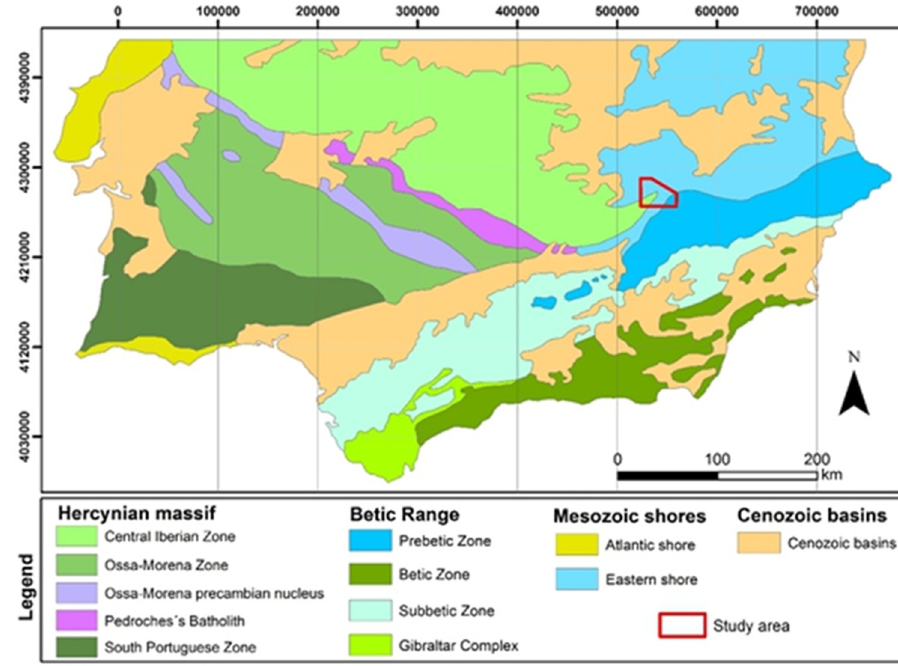
Figure 2. Geological location of the studied area.